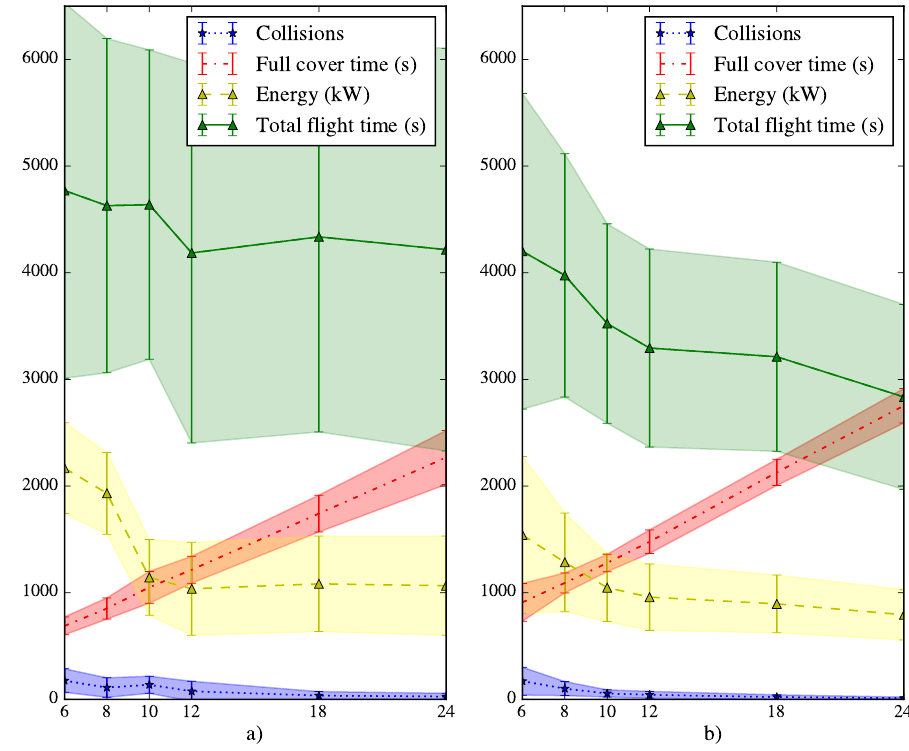
Figure 12. Results of the SLABE ( a ) and SEPHE ( b ) behavior simulations performed on 50 random easy maps. In each simulation, a random start position has been chosen among all feasible locations. Six different take-off time intervals have been tested for each map (6, 8, 10, 12, 18, and 24 s). The average and standard deviation of the number of collisions, the time required to cover 95% of the environment, the energy consumed by the swarm, and the total flight time are